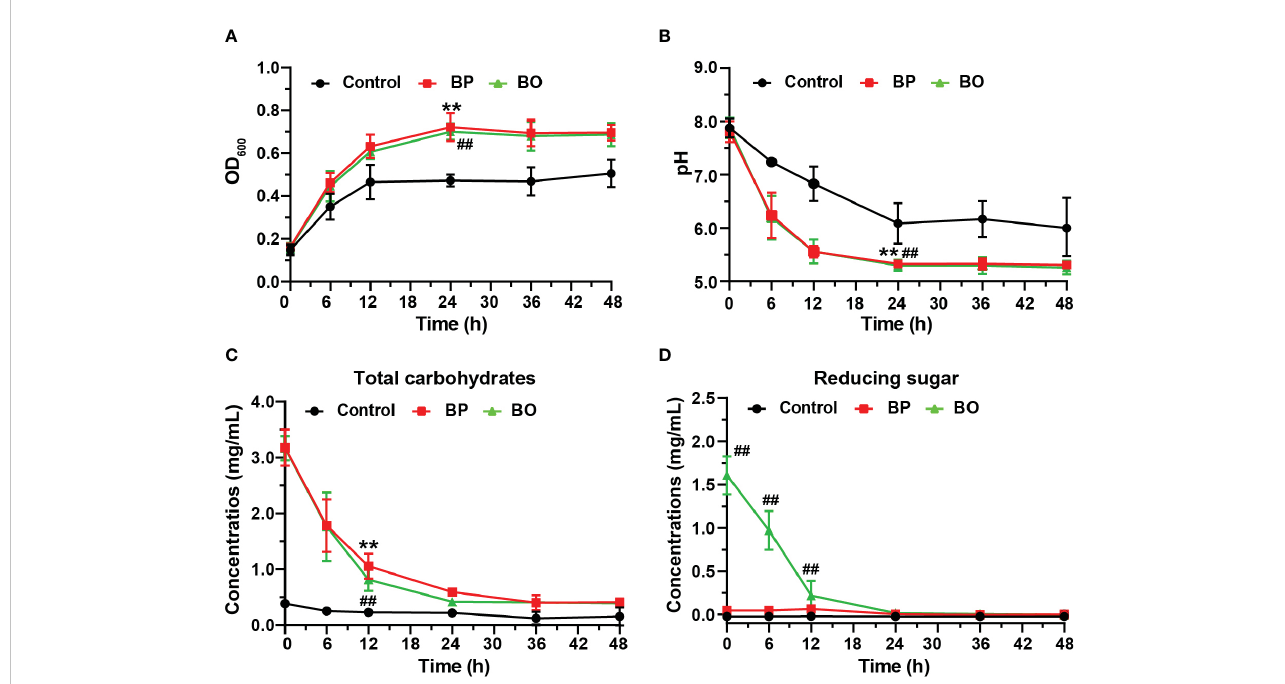
FIGURE 2 Changes of the growth curve, pH value, and fermentation broth composition during in vitro fermentation of BP and BO at different time points. (A) OD 600 values of gut microbiota. (B) pH values offermentation broth. (C) Total carbohydrate changes of fermentation broth. (D) Reducing sugar changes of fermentation broth. Data were presented as mean ± SD (n = 3). ** p < 0.01, Control group vs. BP group; ## p < 0.01, Control group vs. BO group.